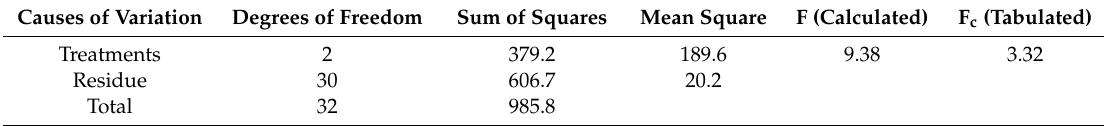
Table 7. HSD test for the tensile strength of the CM sedge fiber-reinforced composites. Volume Fraction of Sedge Fibers